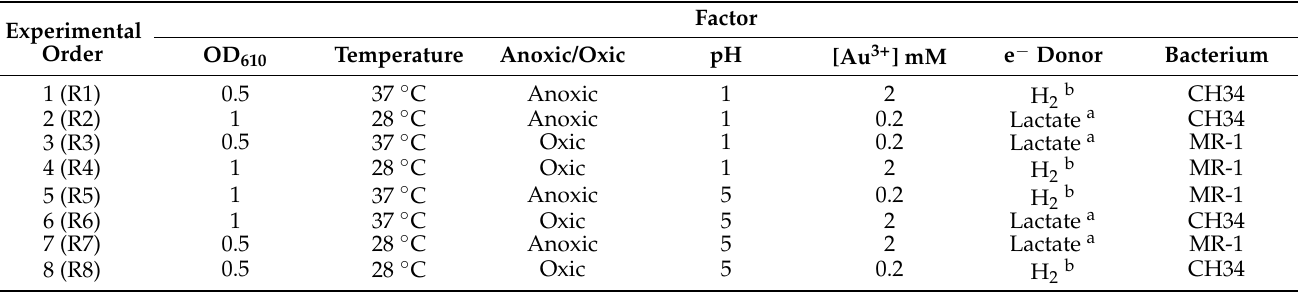
Table 1. Orthogonal matrix as experimental design for gold recovery applied in Resolution (III) fractional factorial of a design of experiments